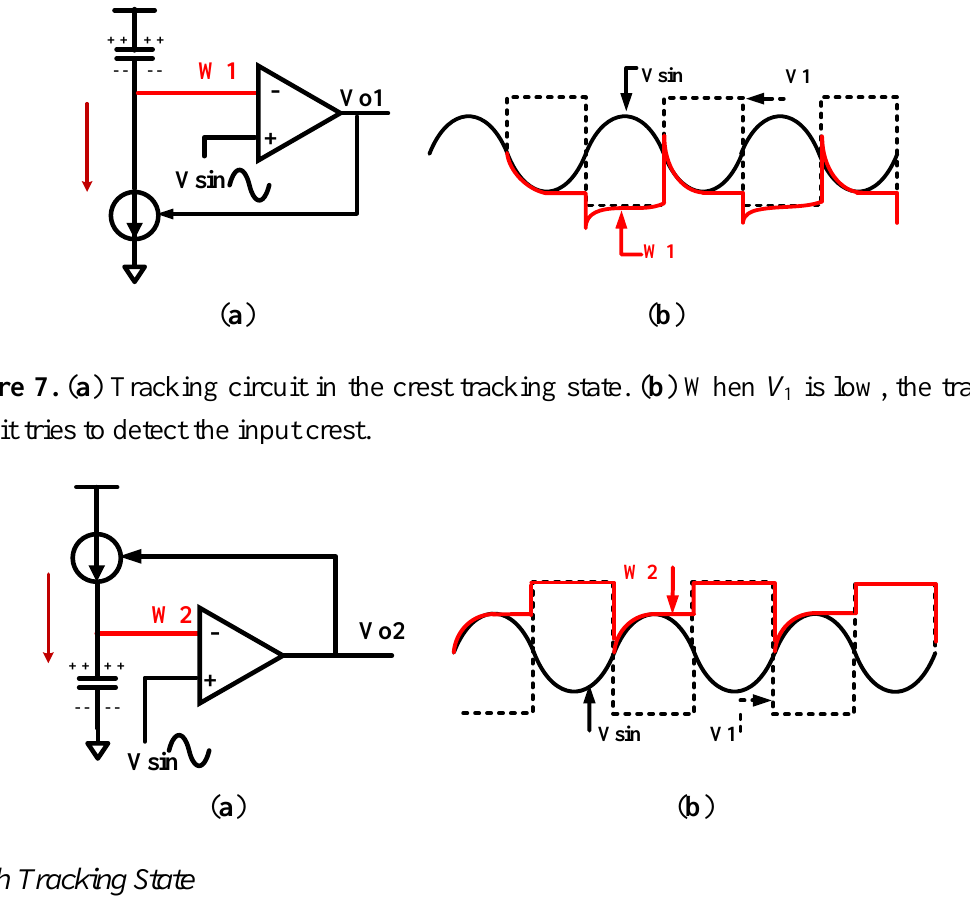
Figure 6. ( a ) Tracking circuit in the trough tracking state. ( b ) When V circuit tries to detect the input trough.